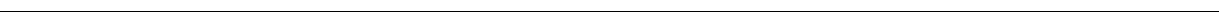
Fig. 4 Silica activity vs. temperature diagrams of mineral stability fi elds. a Mineral stability in the system Ca-Fe-Si-O associated with characteristic assemblages in CV3 chondrites; b Mineral stability in the systems Ca-Fe-Si-O without water ( black ) and Ca-Fe-Si-O-H with excess water. Stability fi eld are calculated at IM redox conditions and an indicative pressure of 2000 bar. Green lines and green area for hydrous phases. The silica activity buffer curve nepheline/albite is also plotted. Characteristic Ca-Fe-rich assemblages in CV3 chondrites allow depicting Log a SiO 2 – T pathway for each CV3 lithologies. As illustrated in b , a single trend matches the diversity of Ca-Fe secondary phases in all CV3 subgroup, suggesting a unique allochemical metamorphism in CV3 chondrites parent body ( gray area and dashed arrow ). Ca-Fe-rich anhydrous phases crystallize fi rst at the highest a SiO 2 due to the intrinsic composition of the unprocessed matrix while rare serpentine-like hydrous phases (Fe-serpentine fi eld in green ) should witness the low temperature part of the fl uid-assisted metamorphic trend ( dashed arrow